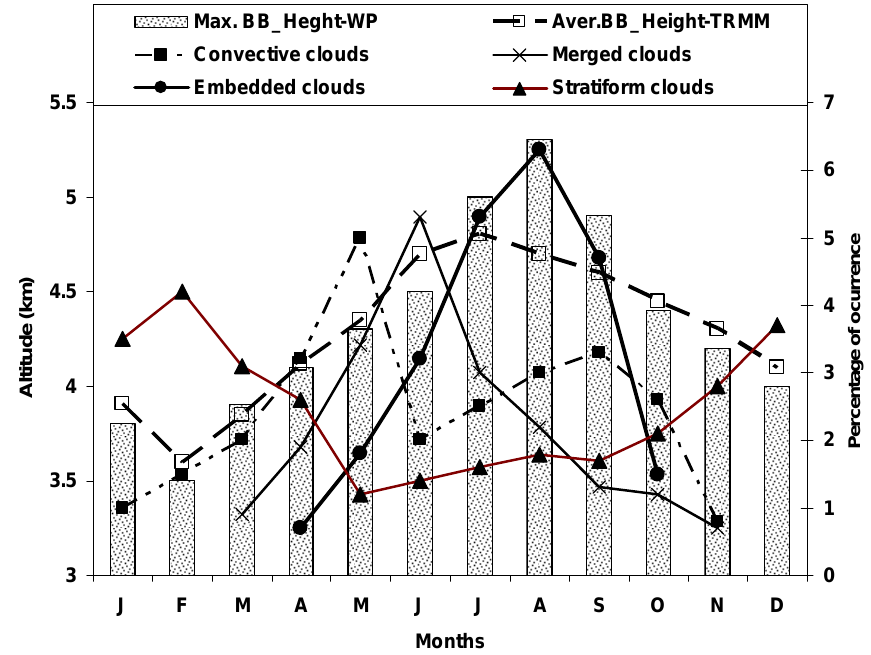
Fig. 4. Monthly occurrence of height of the melting layer/bright band and Occurrence percentage of Convective clouds, Merged clouds, Embedded clouds and Stratiform clouds observed during January to December 2006. Bright band height observations from Wind profiler (indicates as bar, maximum height of the Bright Band and also excluding Typhoon precipitating clouds) and also from Tropical Rainfall Measuring Mission (indicated as dash with open square symbol).